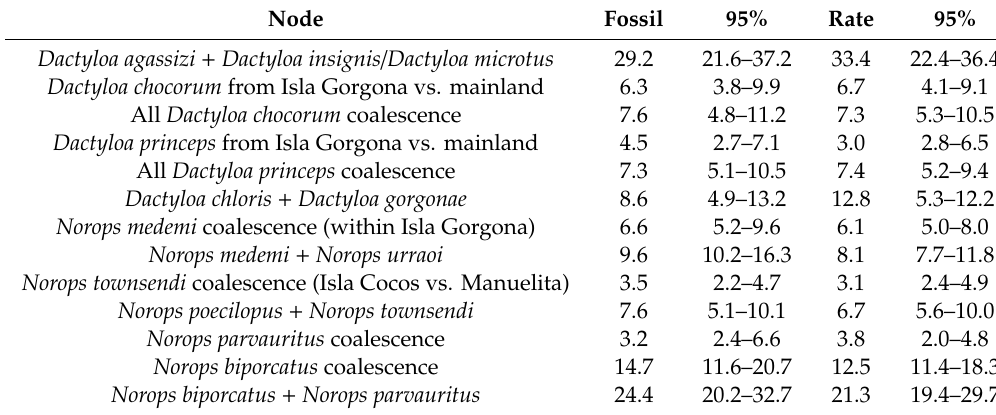
Table 1. Mean dates and 95% confidence intervals for select nodes relevant to Pacific Island anoles, using multiple dating methods (fossil-fossil calibrations + mutation rate; rate = mutation rate